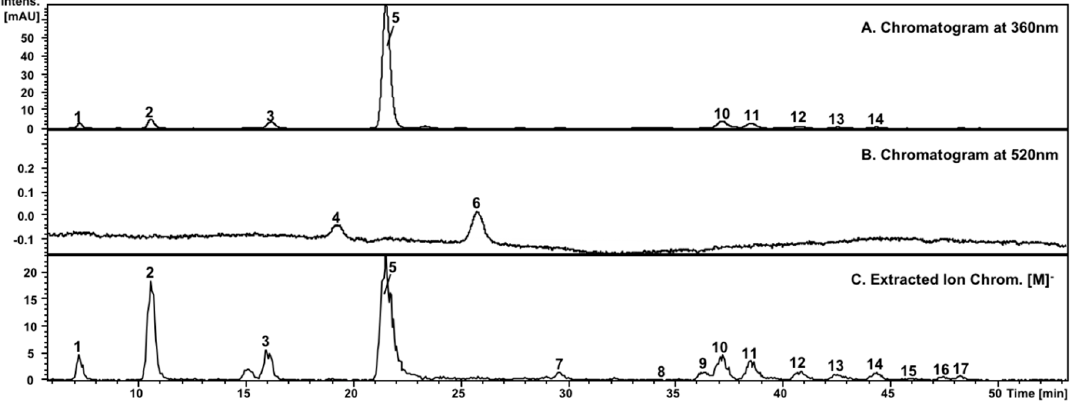
Figure 1. Typical chromatogram of mango organs (e.g., peels), registered at 360 nm ( A ) and 520 nm ( B ) for the identification; Extracted Ion Chromatogram of (M) − of parental ions ( C ) of the phenolic compounds in the mango samples is also included. For the compound assignment numbers, please see Table 3.